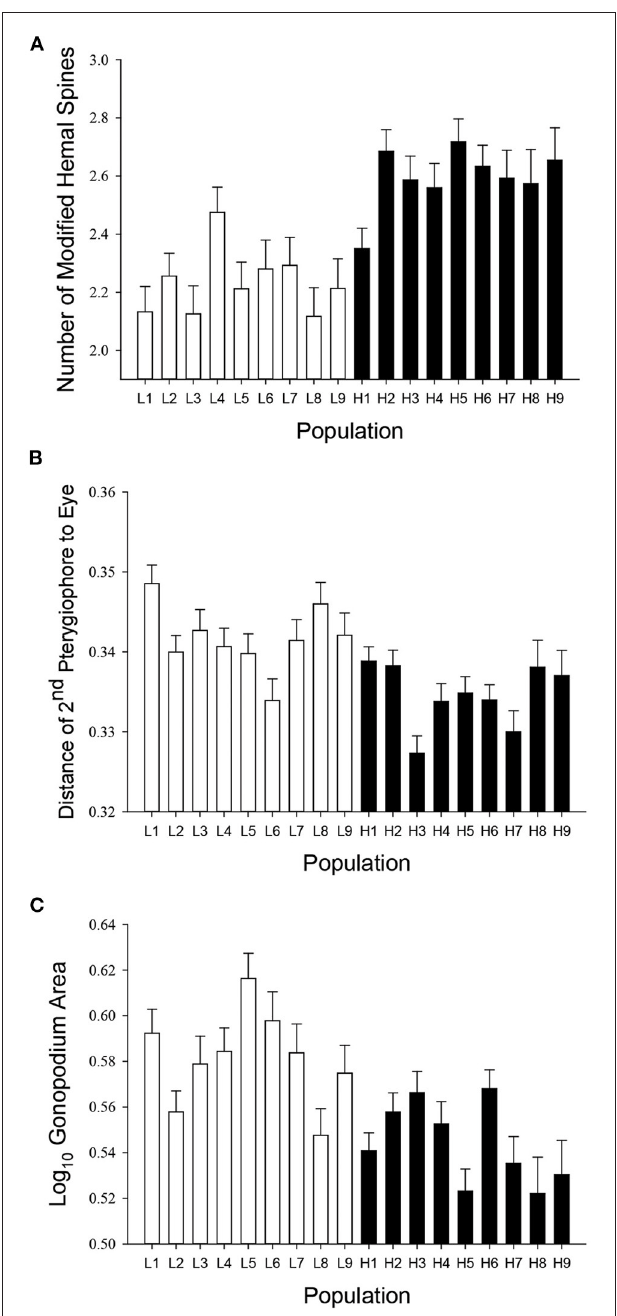
FIGURE 4 | Differences between low-predation (open bars) and high-predation (filled bars) populations of Bahamas mosquitofish in (A) number of modified hemal spines, (B) gonopodial anterior transposition, and (C) gonopodium lateral surface area (see Table 1 for statistical details). Least-squares means ± one standard error